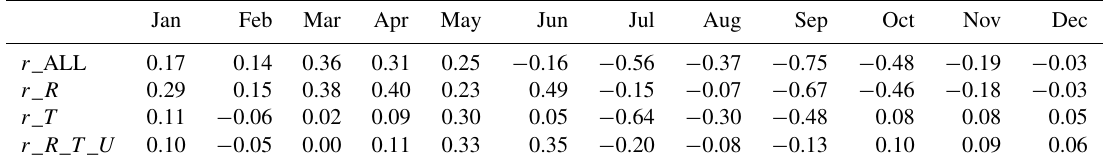
Table 2. Monthly Pearson correlation coefficients of GPP trends ( r _ALL: all variables are not de-trended; r _R: radiation is de-trended; r _ T : air temperature is de-trended; r _ R _ T _ U : radiation ( R ), temperature ( T ), and wind speed ( U ) are all